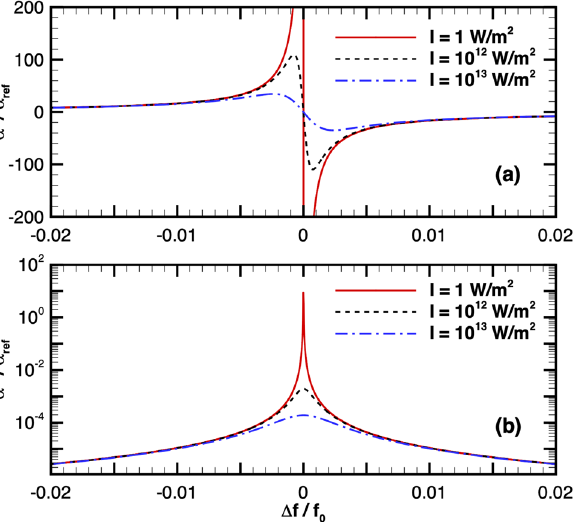
Figure 2. ( a ) Real and ( b ) imaginary component of lithium polarizability over a range of light detuning and for a few light intensities, I . Polarizability is calculated using the resonance wavelength of the D 2 line of (cid:31) 0 = 670.977 nm and spontaneous emission rate, γ